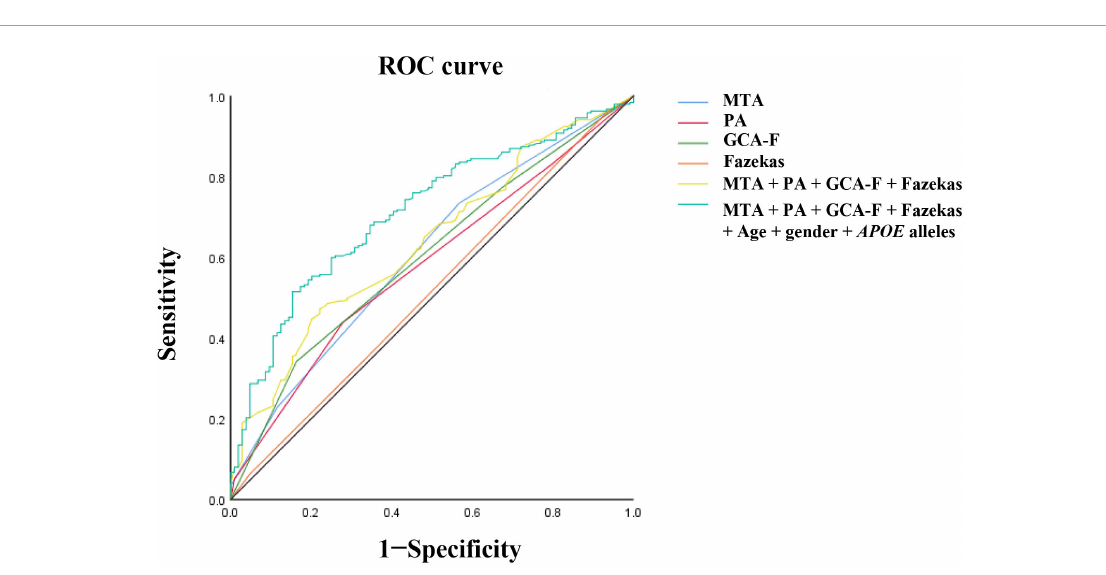
FIGURE2 Receiver operating characteristic (ROC) curve analysis of visual rating scales for disease severity. The MTA exhibited the best predictive efficacy as a single indicator (AUC = 0.622, sensitivity = 74%, specificity = 44.6%). The PA, AUC = 0.59, sensitivity = 44.2%, specificity = 73.2%. The GCA-F, AUC = 0.609, sensitivity = 34.7%, specificity = 84.8%. The Fazekas, AUC = 0.51, sensitivity = 95.5%, specificity = 6.2%. The MTA combined with PA, GCA-F, and Fazekas; the predictive performance significantly improved (AUC = 0.654, sensitivity = 48.3%, specificity = 78.6%). The